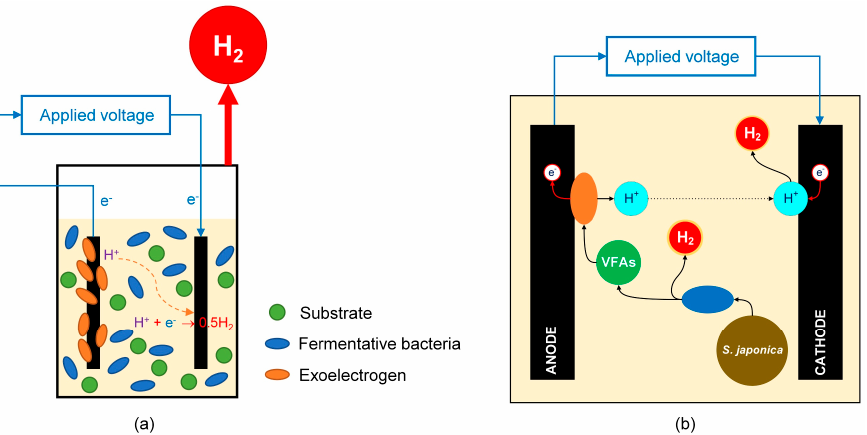
Figure 6. ( a ) Diagram of the single-stage DF and MEC process (sDFMEC) and ( b ) scheme principle of S. japonica -fed sDFMEC. Table 4. Summarization of biohydrogen production from S. japonica via MEC and its combination with DF.